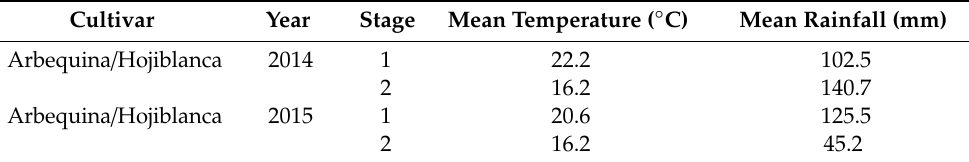
Table 1. Description of the extra virgin olive oil (EVOO)